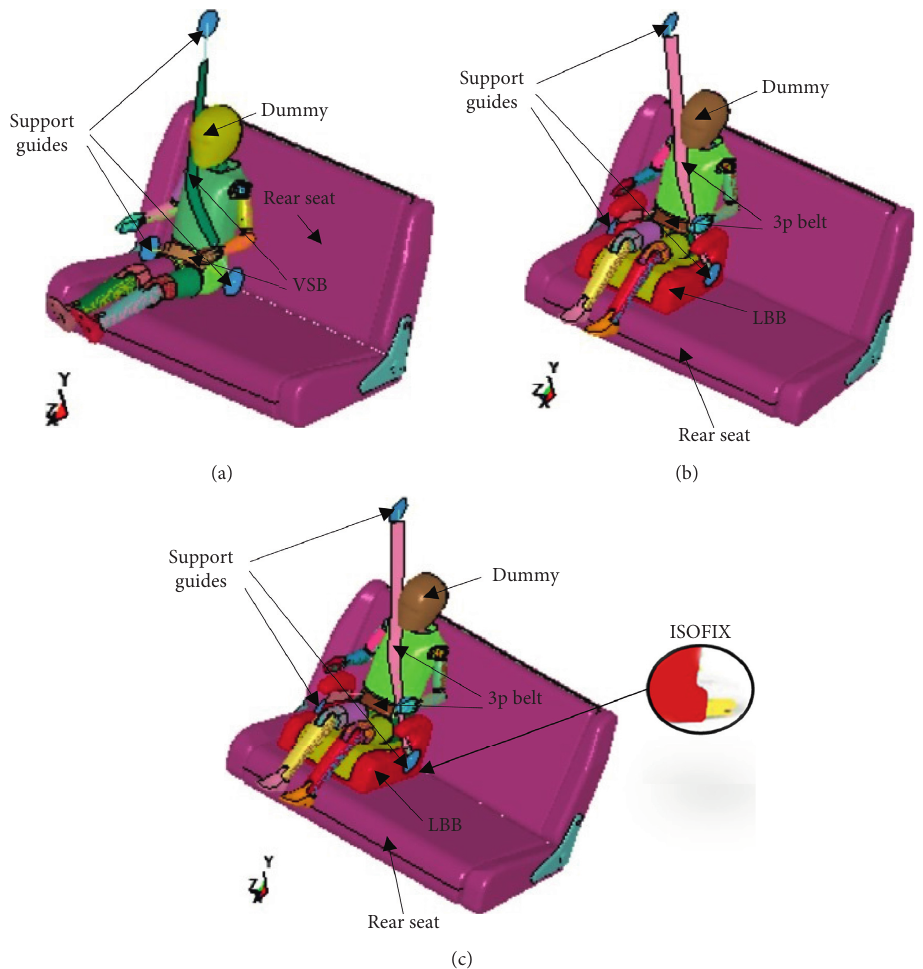
Figure 1: (a) Study (I): only restriction with vehicle safety belt (VSB). The dummy was placed at the back seat of a sedan vehicle and restricted to move by the seat belt implemented. (b) Study II: the dummy was sitting on the LBB and was secured with the 3p seat belt included with the vehicle. (c) Study III: the dummy was sitting in the LBB and secured with the 3p belt and the LBB with the ISOFIX system.